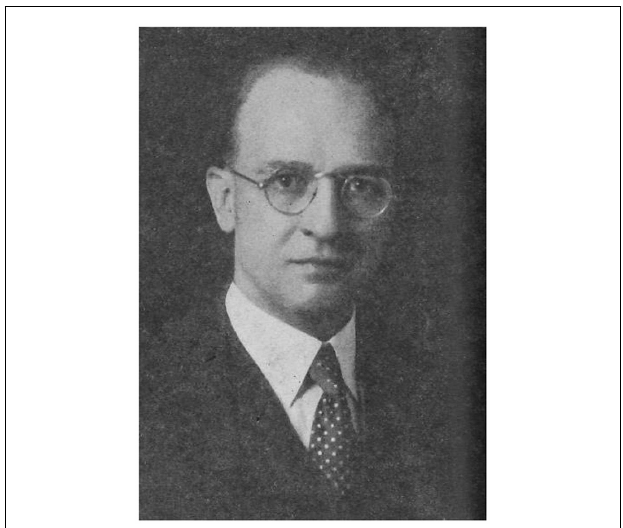
FIGURE 1 | Gordon Scott Fulcher (1884–1971)